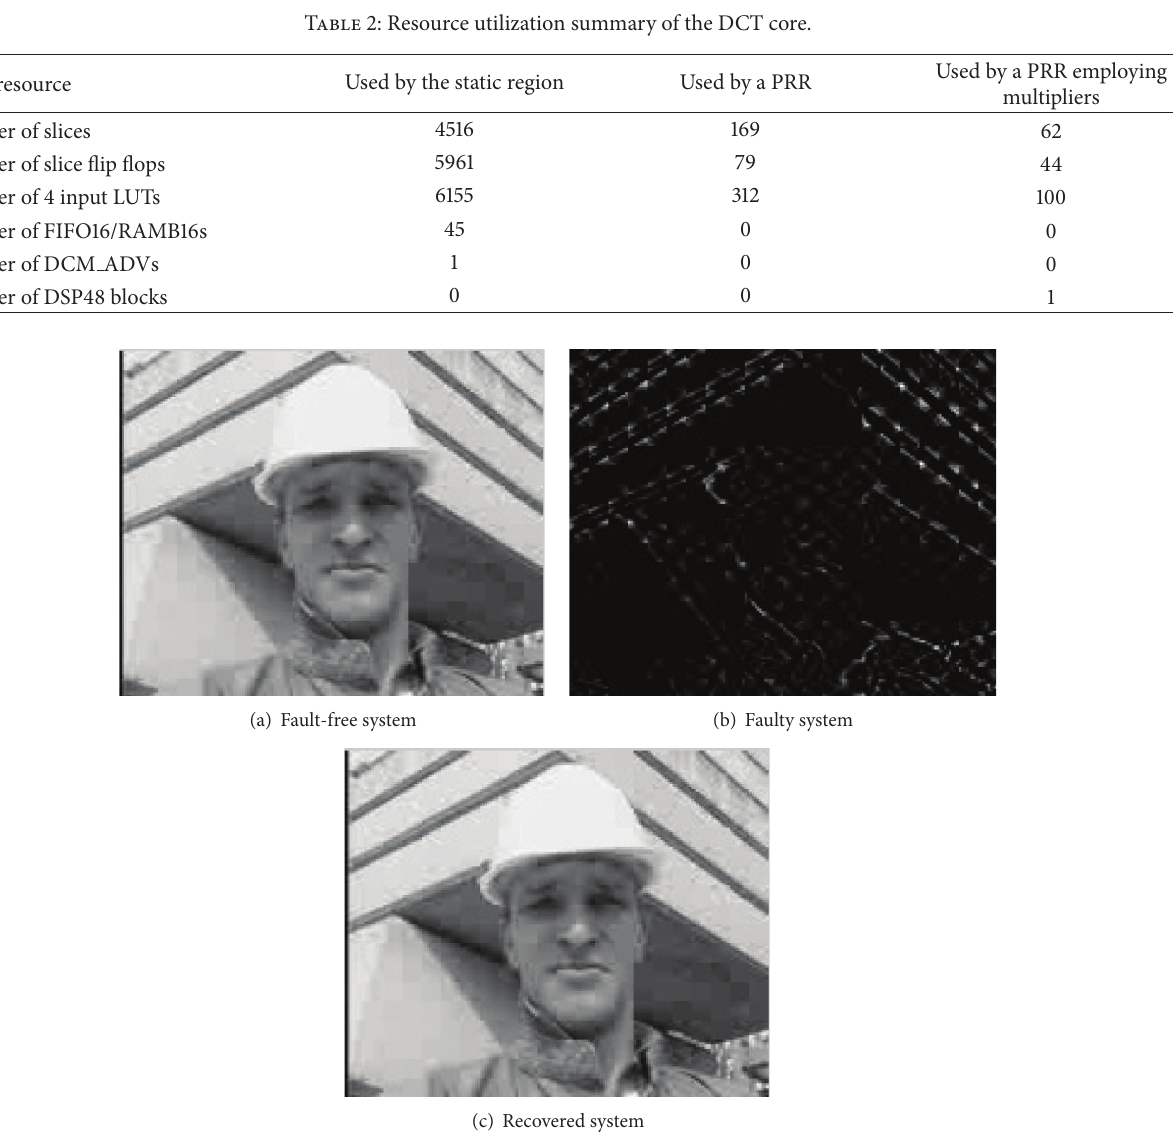
Figure 13: An image in the frame memory of video